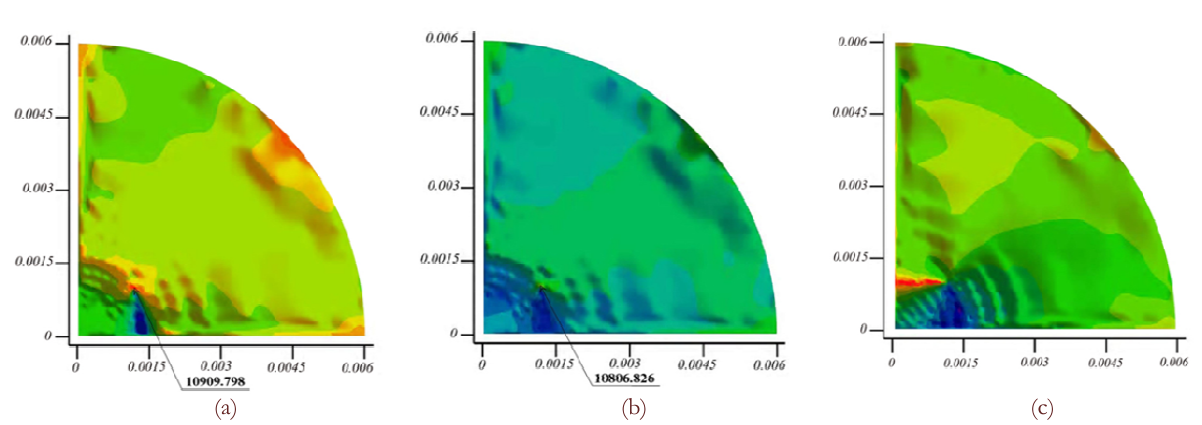
Figure 2: Contour plots for maximum crack length (critical length), solved by MathCAD, (a) Von Misses stress distribution subject to critical loading, (b)Von Misses stress distribution subject to critical loading and thermal conditions, (c) Approximation of crack propagation subject to critical